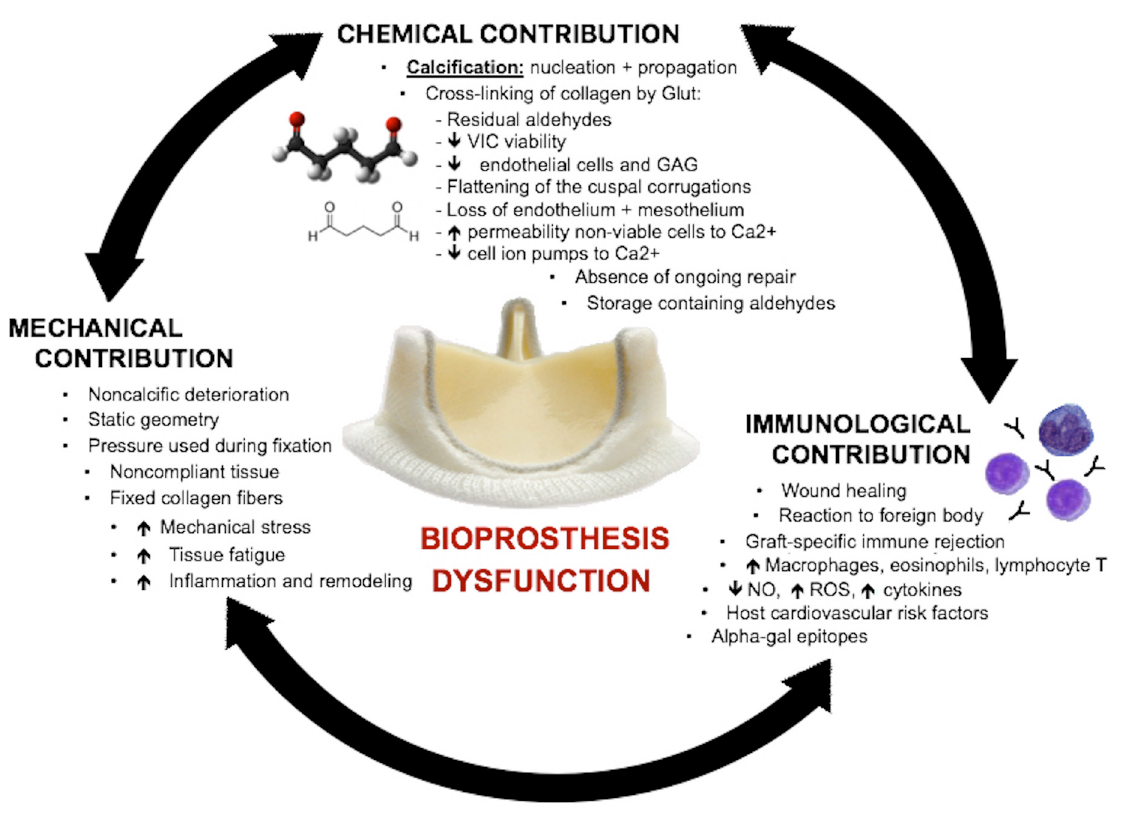
Fig. 2 - Representation of the chemical, mechanical, and immunological factors that contribute to prosthetic valve dysfunction. GAG=glycosaminoglycans; Glut=glutaraldehyde; NO=nitric oxide; ROS=reactive oxygen species; VIC=valvular interstitial